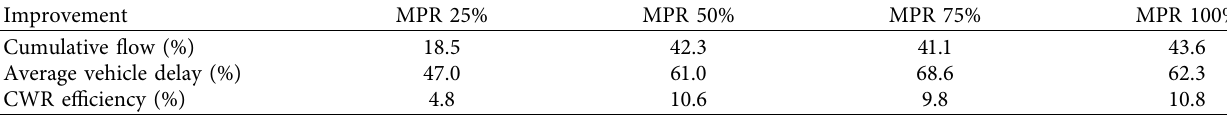
Table 7: Efect of CWR intersection signal control: intersection type 2.